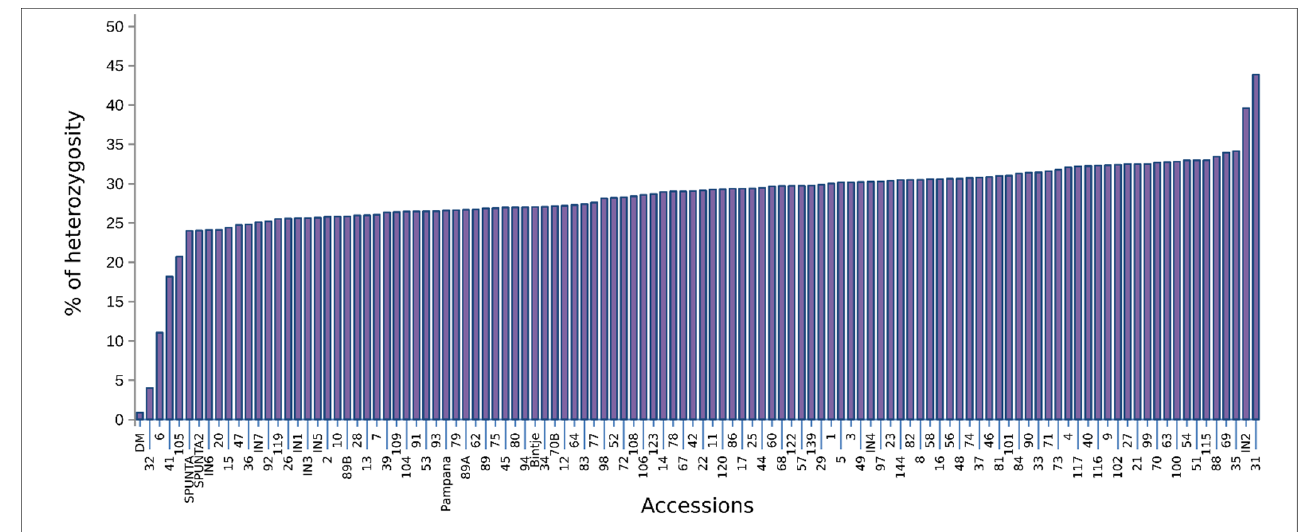
Figure 2. Percentage of heterozygous loci for each of the 114 accessions was determined with 5035 SNPs and a diploid genotyping